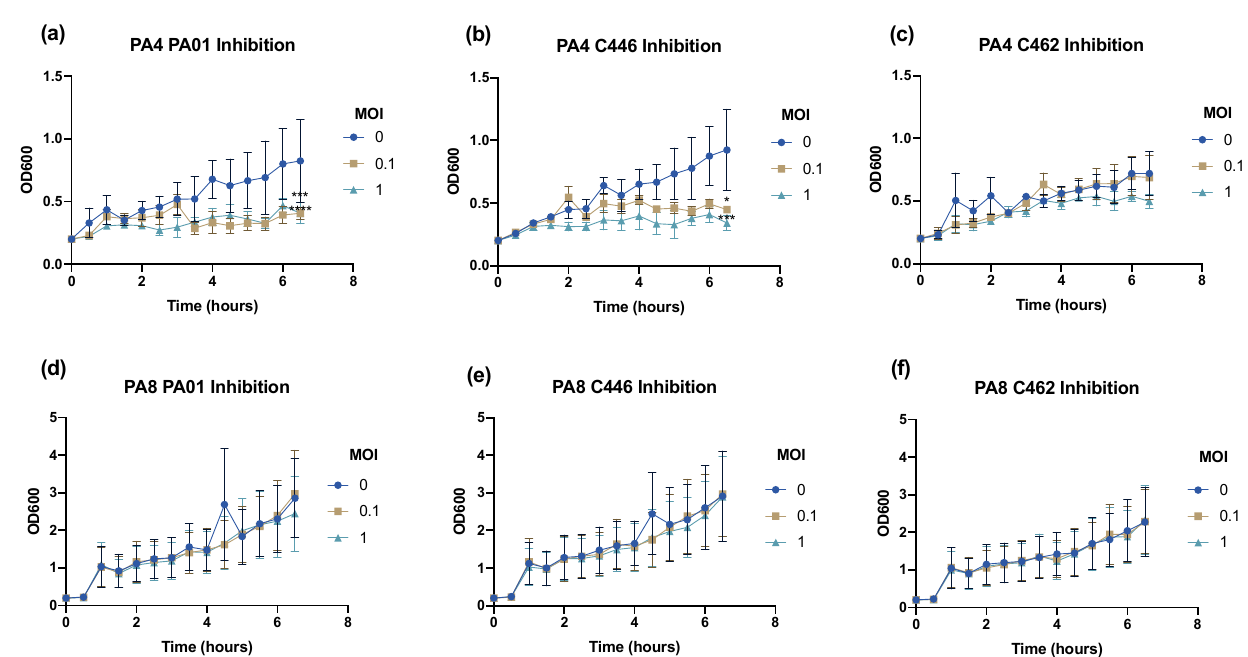
Figure 3. Bacteriophage Inhibition Assays. Inhibition of 1 CF (C462), 1 non-CF (C446) clinical isolate and PA01 reference strain after treatment with PA4 ( a – c ) and PA8 ( d – f ) at a multiplicity of infection (MOI) = 0.1 and 1 compared to untreated control. Data expressed as mean ± SEM for three independent experiments. *, p < 0.05; ***, p < 0.001; ****, p < 0.0001.